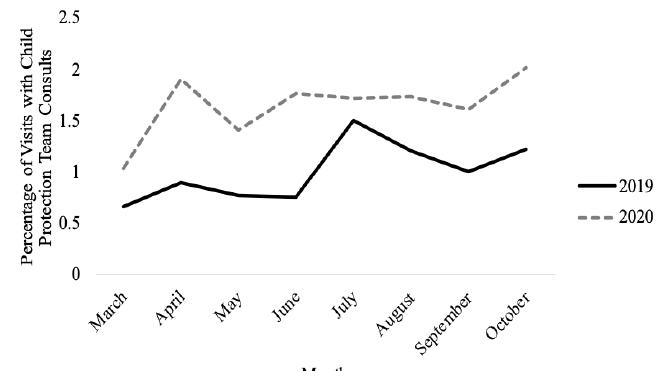
Figure 2. Percentage of emergency department visits with Child Protection Team consults from 2019-2020.